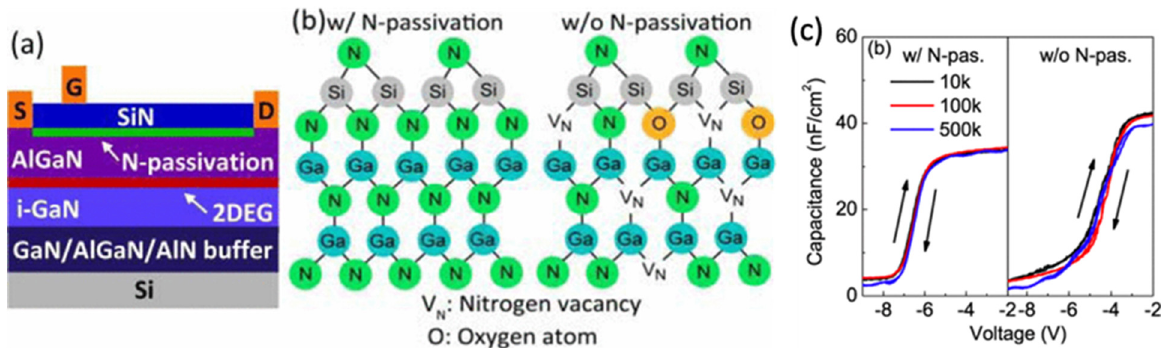
Figure 17. ( a ) Cross-section of the AlGaN/GaN HEMT with N passivation and 20 nm SiN gate dielectric layer. ( b ) Schematic of the atomic arrangement at SiN/GaN interface with and without N passivation. ( c ) C–V characteristics of SiN/GaN MIS capacitor with and without N passivation at different frequencies varying from 10 to 500 kHz [87] . Figure reproduced with permission from IEEE Electron Device Lett.